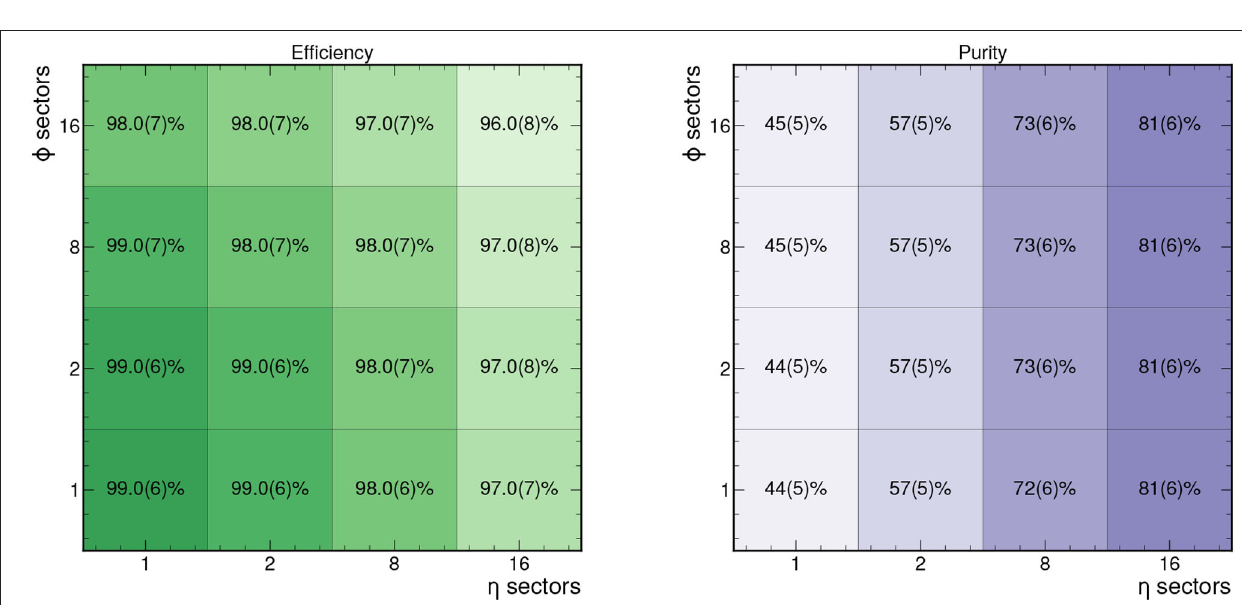
FIGURE 3 | Efficiency (left) and purity (right) of the hitgraphs studied for different numbers of η and φ sectors based on 50 events in train_1 .